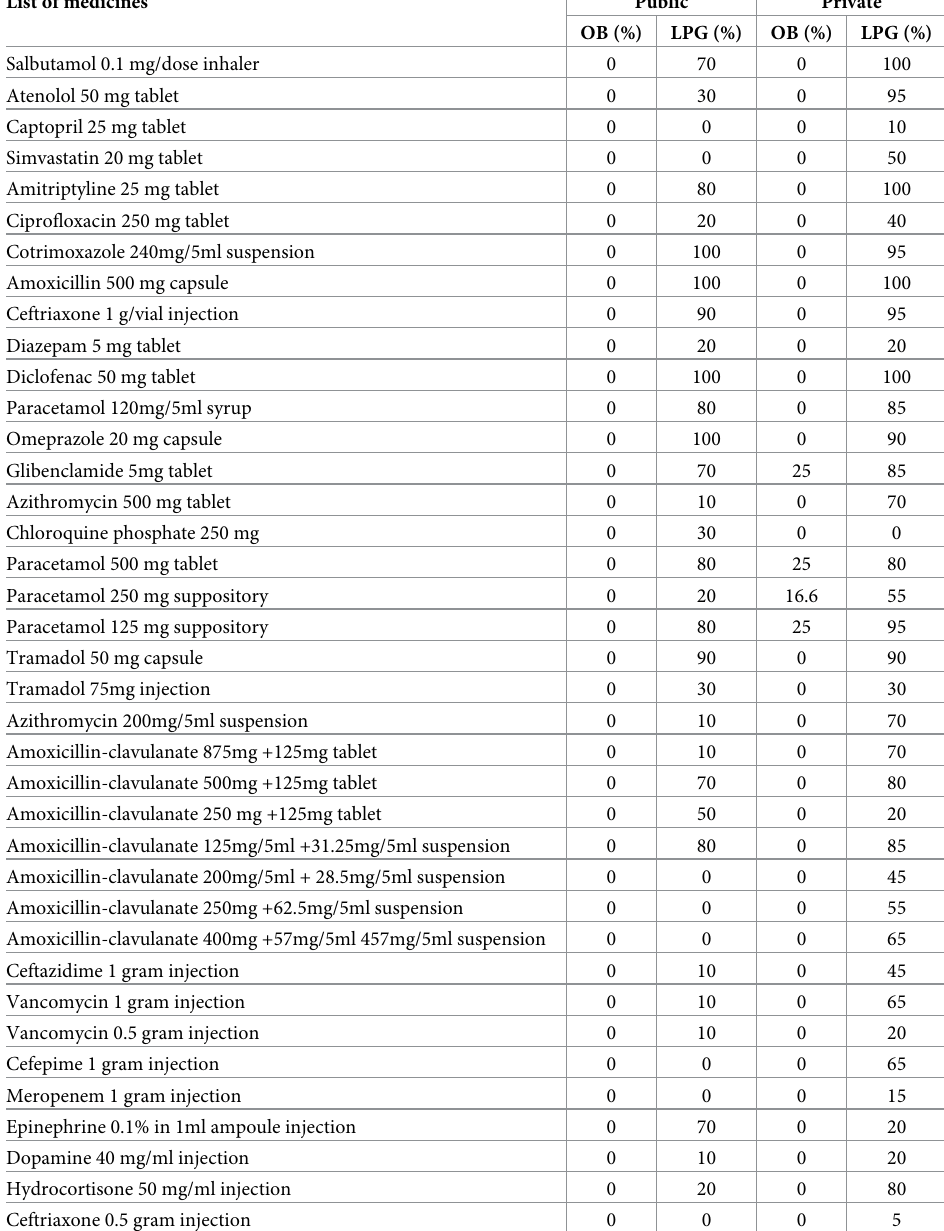
Table 2. Point availability of medicines in health facilities of Dessie town, 2021. List of